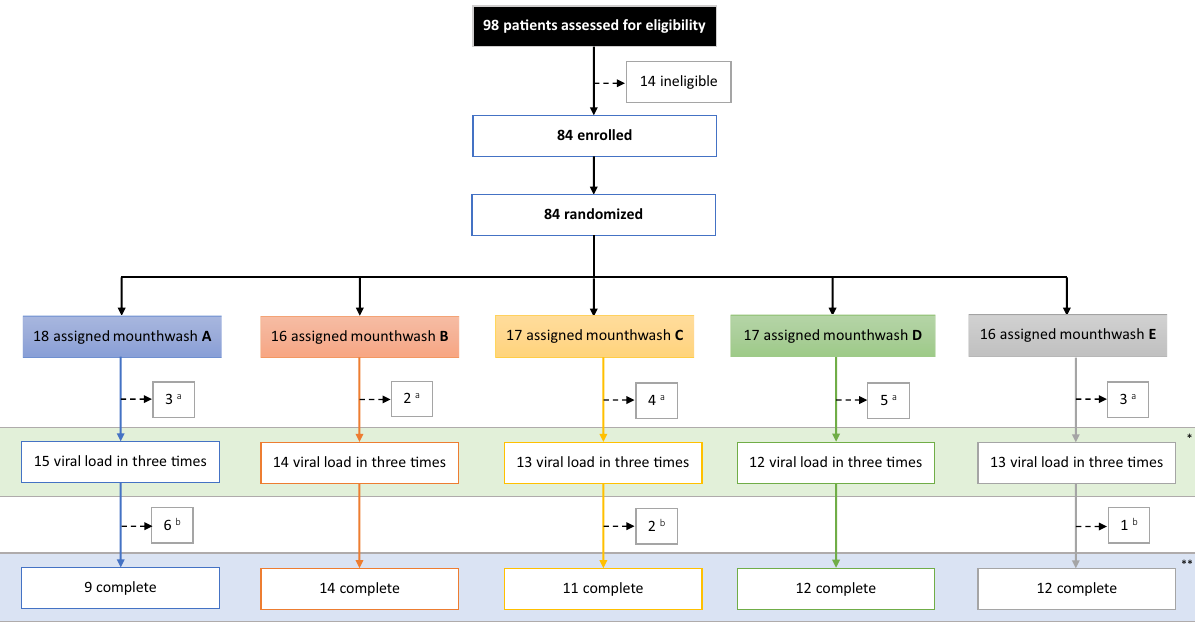
Figure 2. Trial profile. Boxes display the number of individuals recruited for the clinical study and those assigned to each treatment, indicating the number of samples discarded due to undetectable viral load. a No viral load detected at all four times. b No viral load detected in any one of the four sampling times. *Unpaired statistical analysis (three samples per patient available, including basal values). **Paired statistical analysis (all four samples